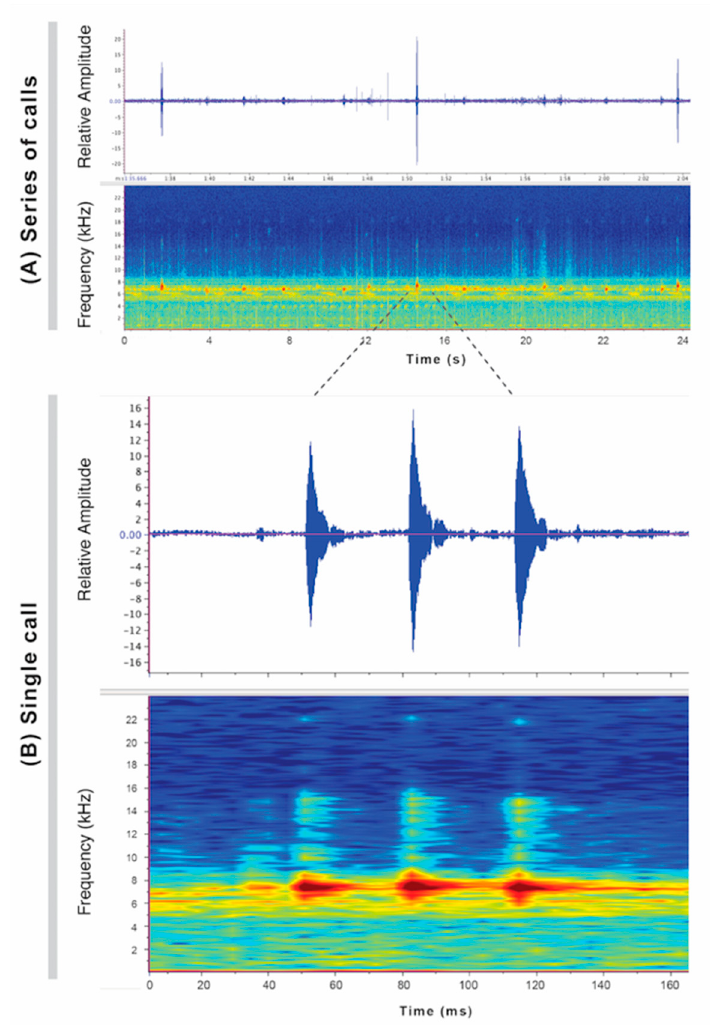
Figure 213. Calls of Teratohyla midas , LBE-C-036, recorded at Boanamo community, 240 m, Orellana province, Ecuador, by Morley Read. ( A ) Call series: fragment showing 3 calls. ( B ) Single call. Tadpole: Not described.